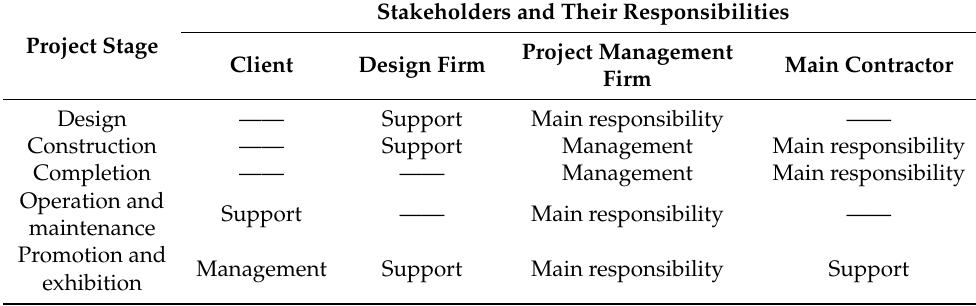
Table 2. Responsibility matrix for BIM